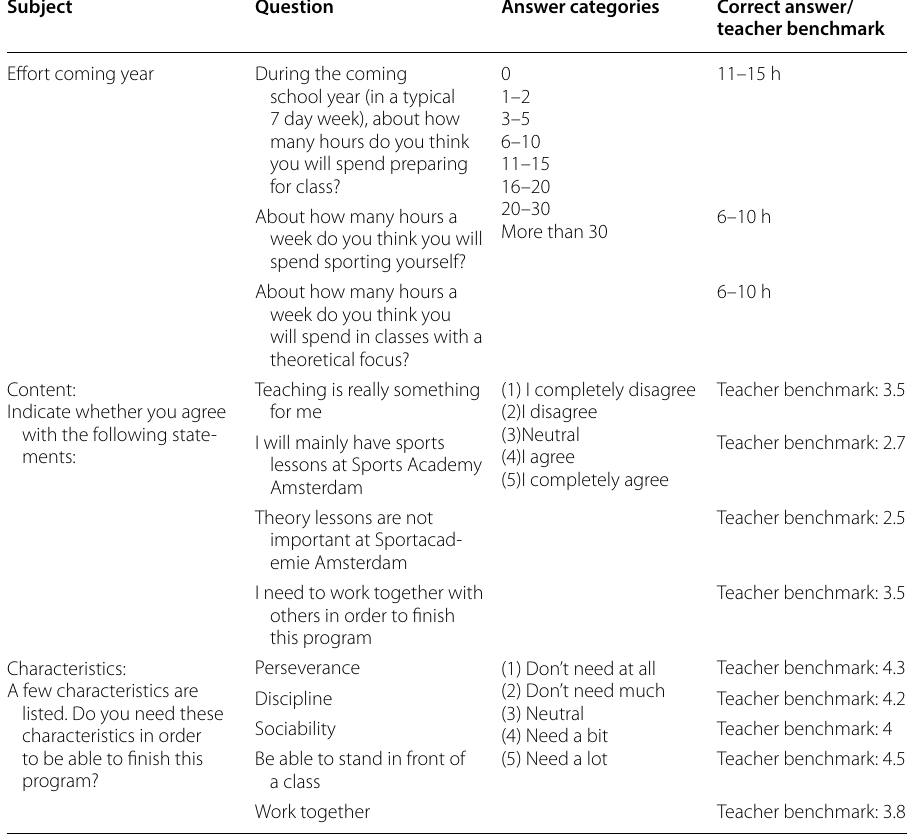
‘Correct answers’ are formed using administrative data and answers from